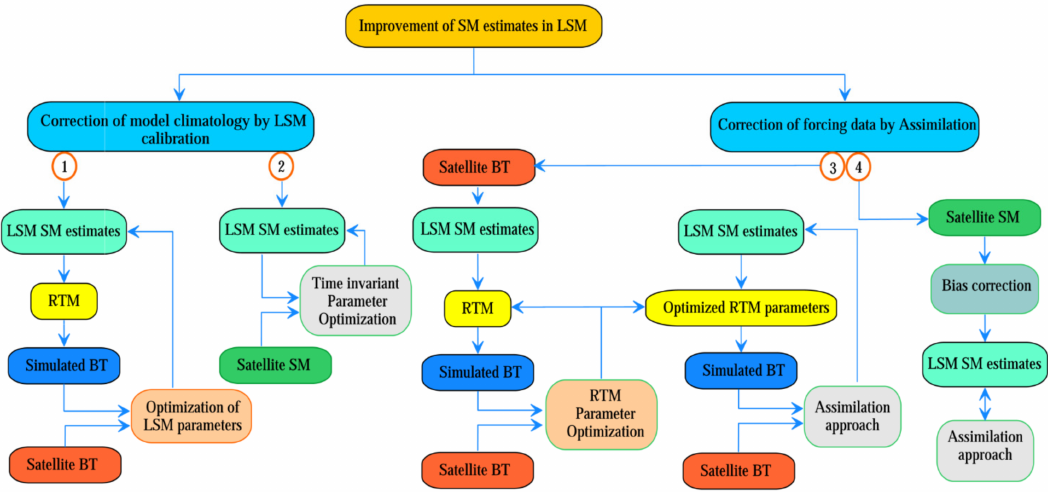
Figure 2. The current procedures for calibration of LSM and RTM and assimilation approaches.